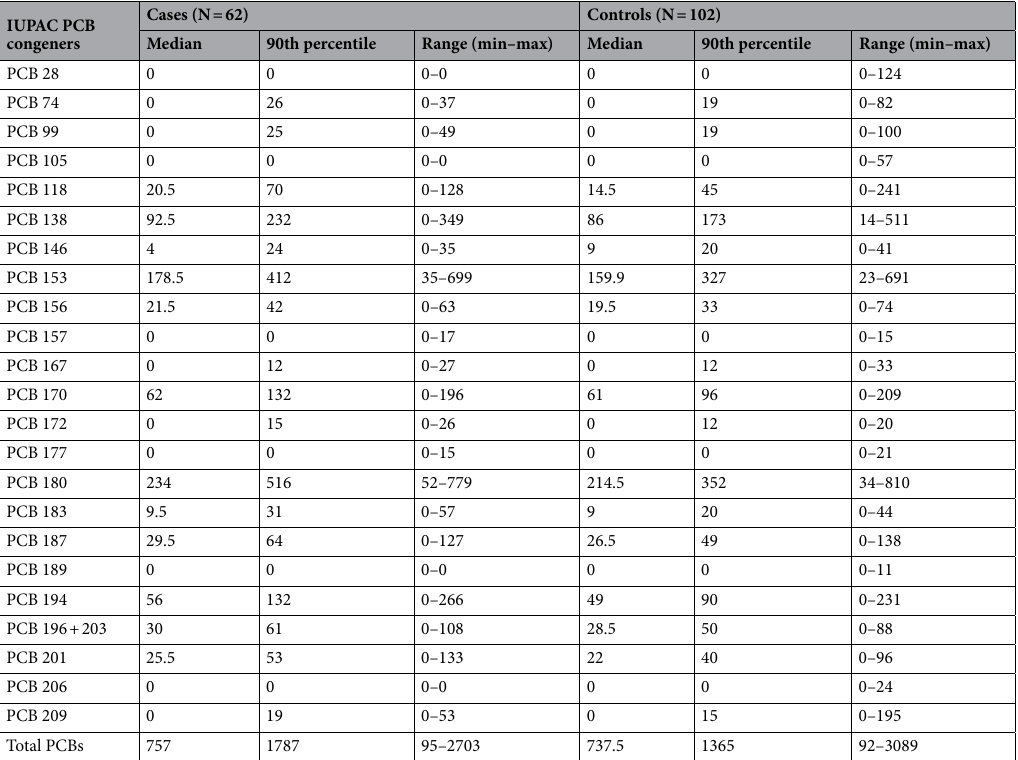
Table 2. Median, 90th percentile and range of lipid-adjusted serum levels of polychlorinated biphenyl (PCB) congeners and total PCBs, in ng/g lipids, in HCC cases and healthy controls.